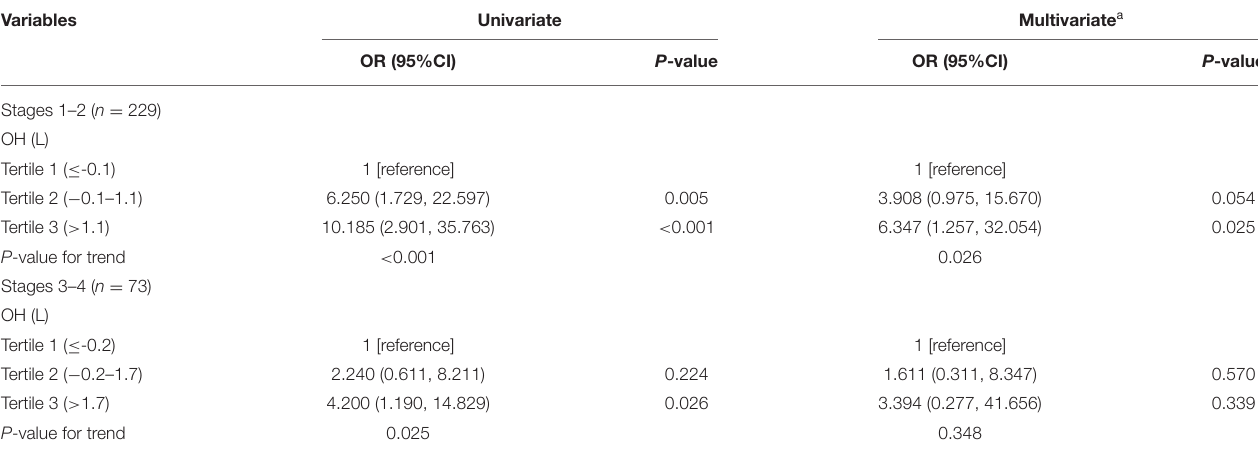
TABLE 4 | Univariate and multivariate logistic regression for the association between OH and LVH in CKD patients with stages 1–2 and 3–4. Variables Univariate Multivariate a OR (95%CI) P -value OR (95%CI) P